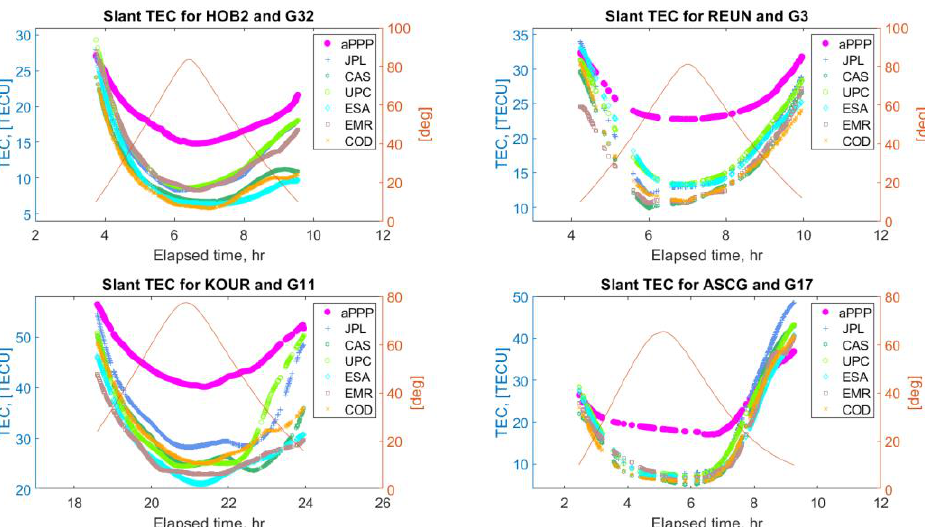
Figure 14. Comparison of STEC values retrieved using the ionosphere retrieval equation (labeled as aPPP) and GIM STEC values from six different Ionosphere Associate Analysis Centers (IAAC) for IGS stations HOB2, REUN, KOUR, ASCG, and GPS satellites G32, G3, G11, and G17. The elevation angles of the corresponding satellites are also plotted.